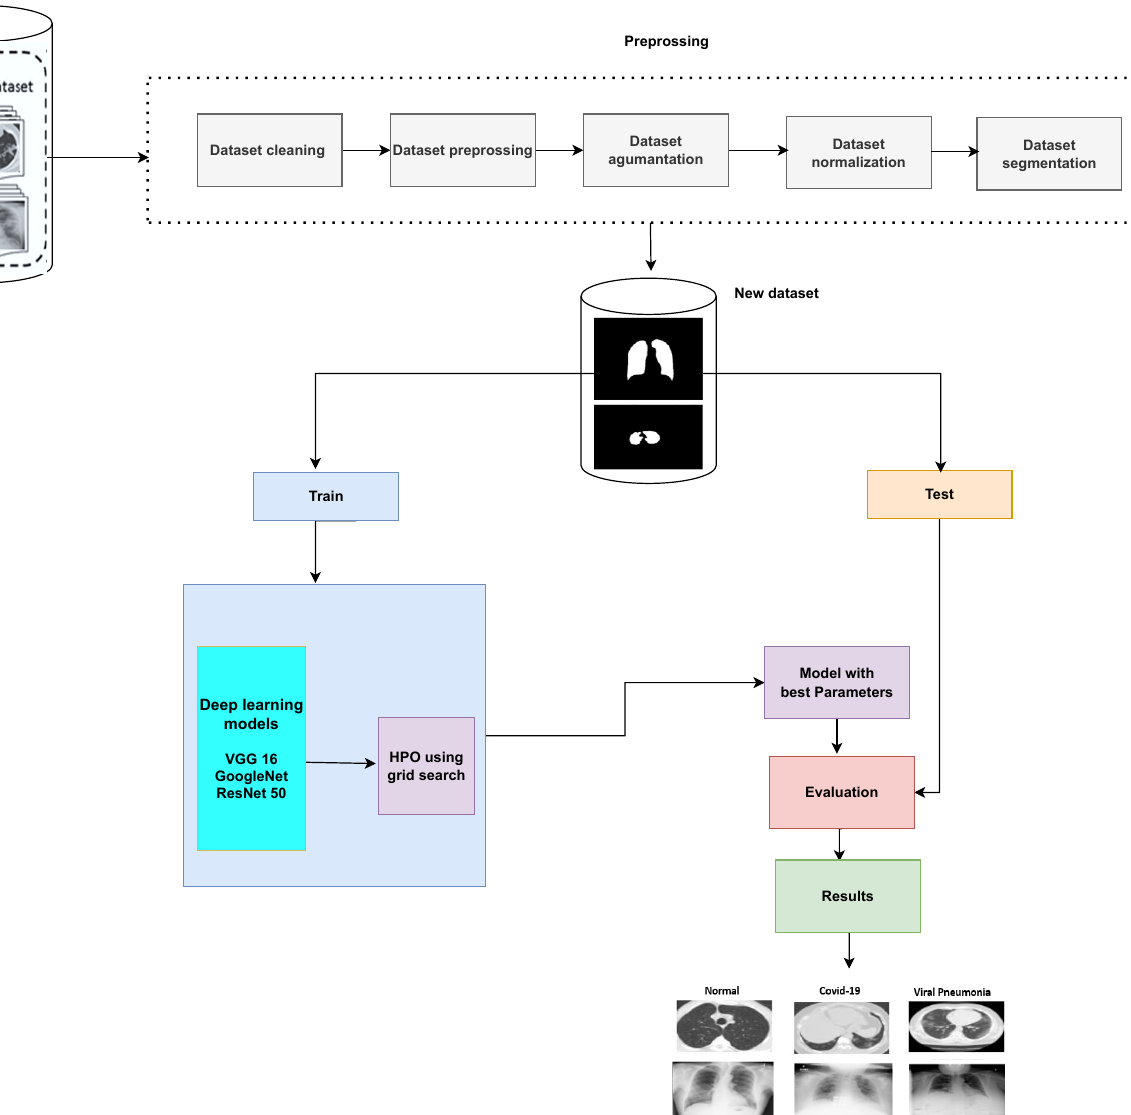
Figure 1. Image classification using optimal CNN